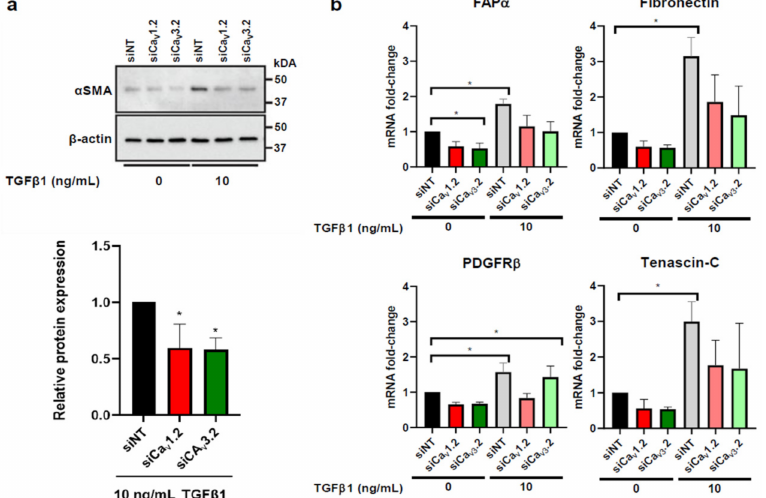
Figure 4. Effect of Ca V 1.2 and Ca V 3.2 silencing on TGF β 1-induced CAF marker expression in HMF3S cells. ( a ) Representative immunoblot and densitometry data showing significant downregulation of α SMA protein expression in the presence of siCa β 1 treatment increased V 1.2 and siCa V 3.2. ( b ) TGF mRNA levels of CAF-associated genes FAP α , PDGFR β , fibronectin, and tenascin-C compared with vehicle. siCa V 1.2 and siCa V 3.2 reduced induction of FAP α , fibronectin, and tenascin-C while PDGFR- ± SD from β induction was inhibited with siCa V 1.2 but not siCa V 3.2. Data are represented as mean three independent experiments; * p < 0.05 from post-hoc Dunnett’s multiple comparison test after one-way ANOVA revealed significant effect of treatments.